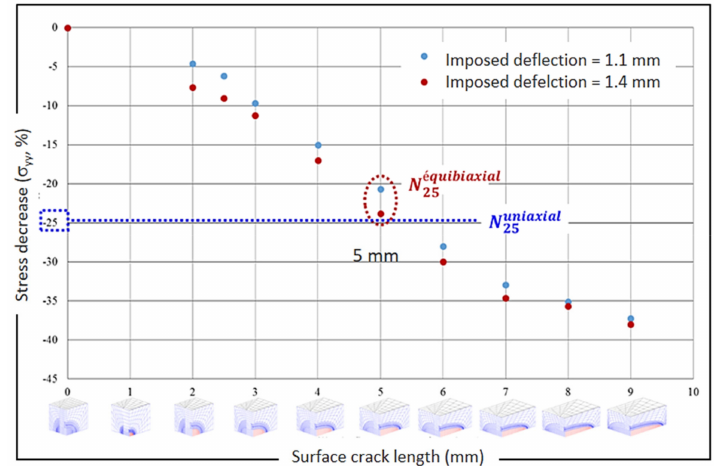
Figure 11. Evolution of the normal stress in the plane of the applied crack as a function of the size of the crack.